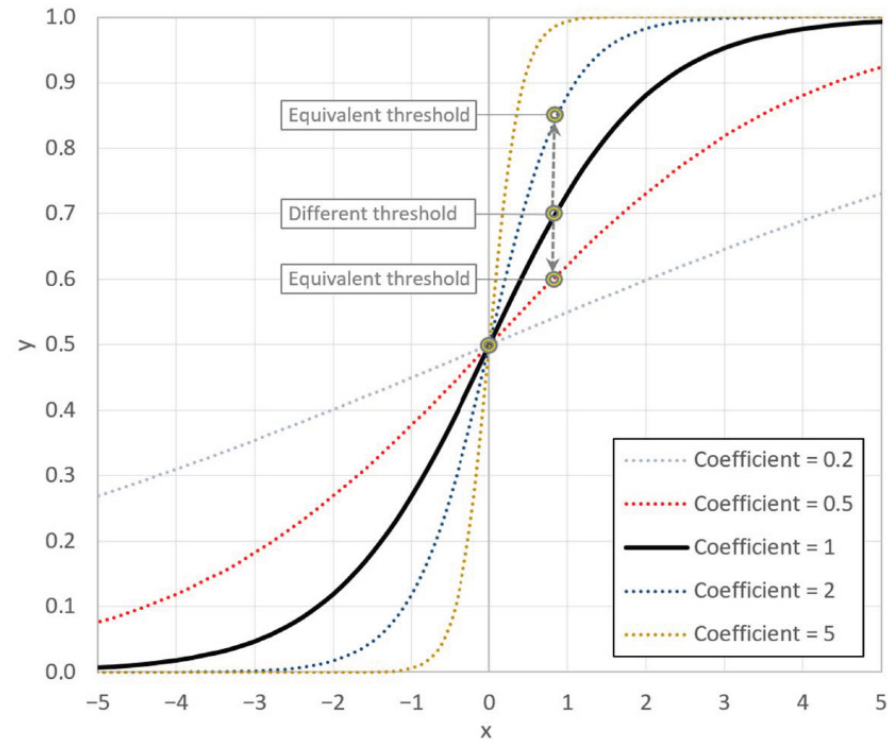
Figure 1. The coefficient value effect on the function slope.